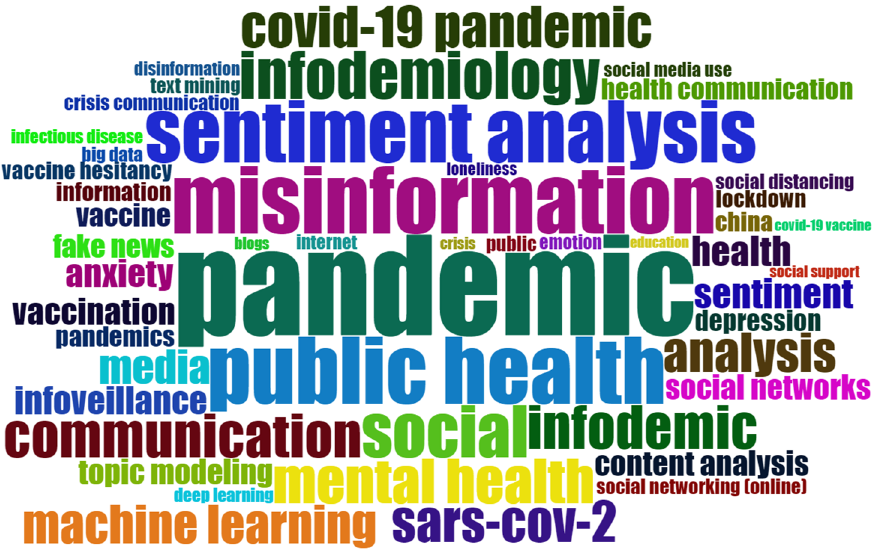
Figure 4. Word cloud based on author keywords (this word cloud was generated by Biblioshiny).